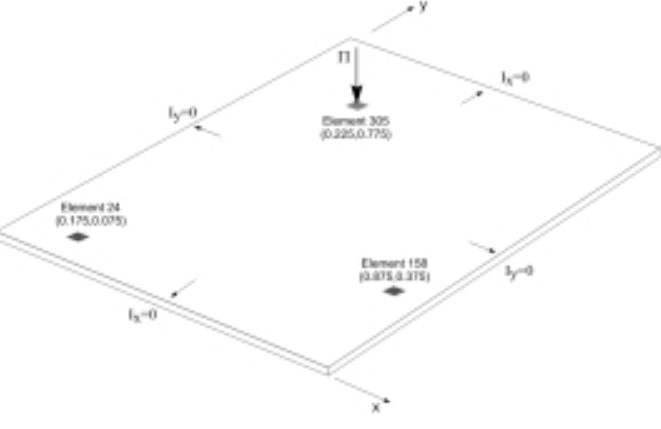
Fig. 11. Thin plate model with center node coordinates ( x,y ) for the excitation and damage elements.